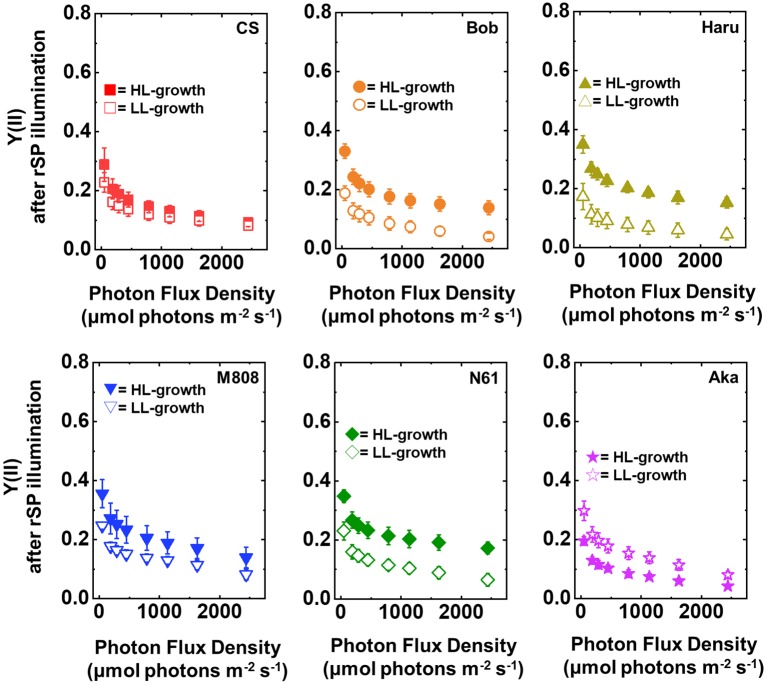
The response of Y(II) to light intensity in six wheat cultivars grown under LL (open symbol) and HL (closed symbol) conditions after rSP illumination for 1 h. The measurement was conducted under atmospheric conditions (21 kPa O2, 40 Pa CO2) at 25°C. Data are expressed as mean ± SD of three to four independent experiments. Red squares indicate the results of CS, orange circles indicate the results of Bob, dark yellow triangles indicate the results of Haru, blue inverted-triangles indicate the results of M808, green diamonds indicate the results of N61, and purple stars indicate the results of Aka.